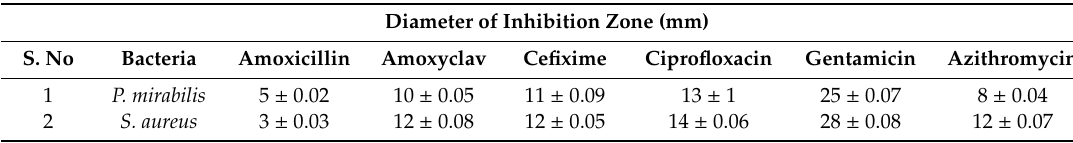
Table 1. Antibiotic sensitivity profiles of